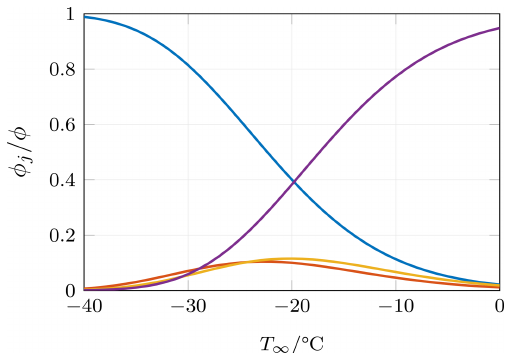
Figure 3. Relative contribution to the total volume fraction by hy- drometeors in a certain regime. Linestyles: axisymmetric regime (blue), steady oblique regime (red), oscillating oblique regime (yel- low) and chaotic regime (purple).